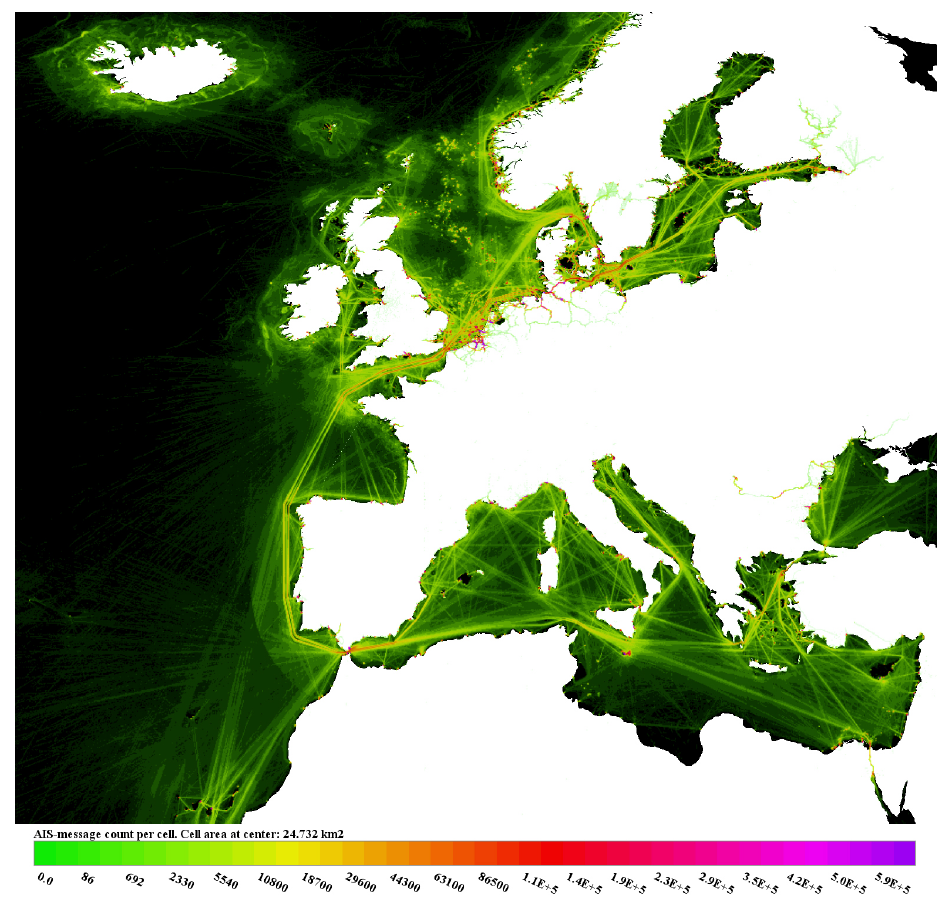
Figure 1. The geographical coverage of the terrestrial AIS network in Europe. The colour scale illustrates the number of position reports per unit area, received in the EU sea areas in